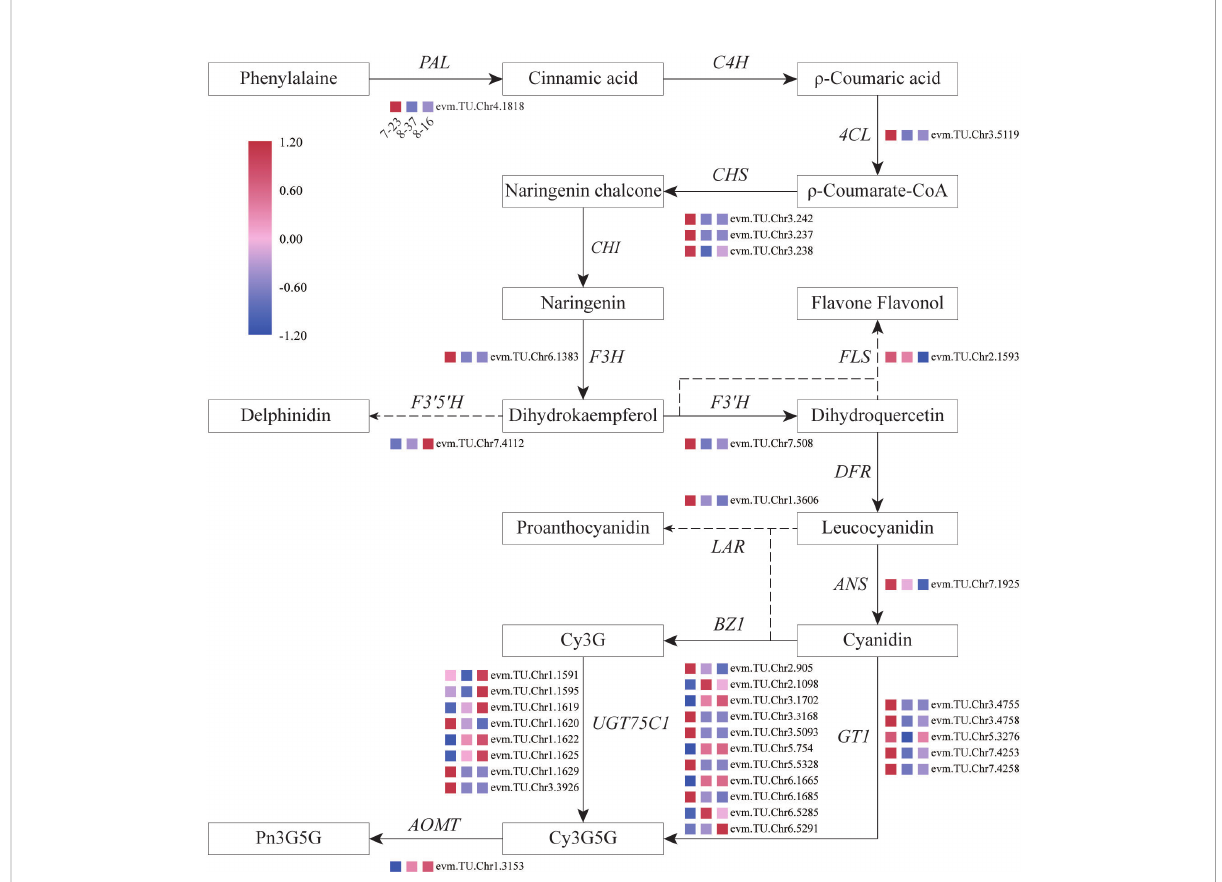
FIGURE 4 Overview of the pathway of anthocyanin biosynthesis and temporal expressional patterns of related DEGs. 4CL , 4-coumaroyl-CoA synthase; ANS , anthocyanidin reductase; AOMT , anthocyanin O -methyltransferase; BZ1 , anthocyanidin 3- O -glucosyltransferase; C4H , Cinnamic acid 4-